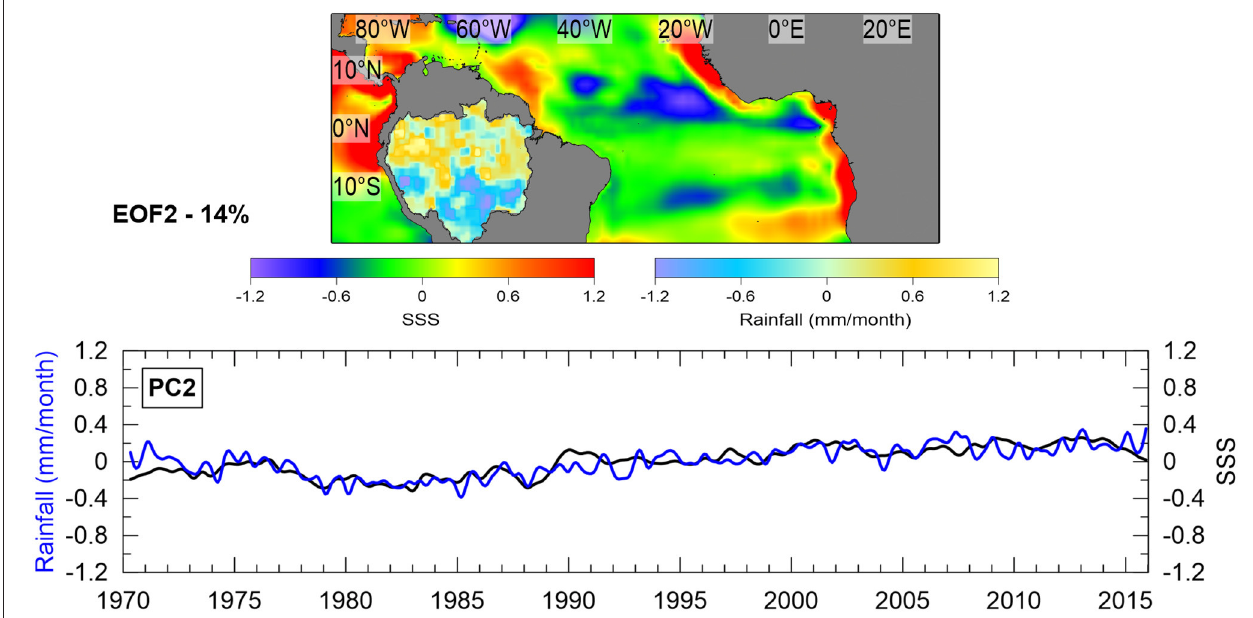
FIGURE 5 | Second EOF of 3 month-lagged covariance matrix between rainfall (normalized scale by 10 3 ) and SSS (normalized scale by 10), the Squared Covariance Fraction (SCF) in percentage, and the second Principal Component (PC2).